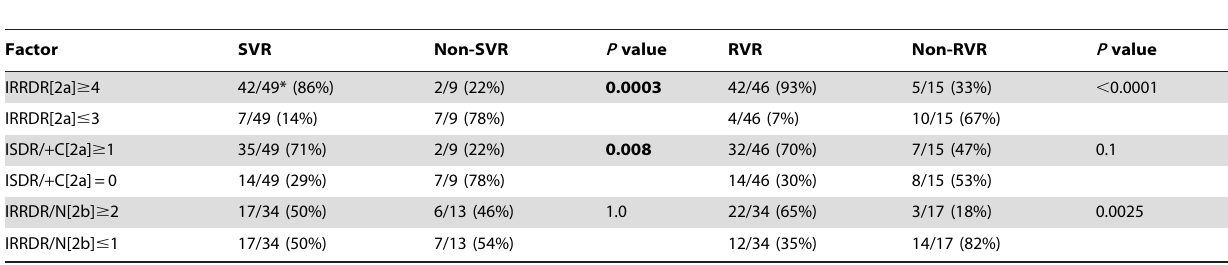
*No. of isolates with a given factor/total no. of SVR or RVR. Abbreviations: SVR, sustained virological response; RVR, rapid virological response; IRRDR[2a], interferon/ribavirin resistance-determining region of HCV-2a; ISDR/ + C[2a], part of interferon sensitivity determining-region plus its carboxy-flanking region of HCV-2a; IRRDR/N[2b], an N-terminal part of interferon/ribavirin resistance- determining region of HCV-2b.